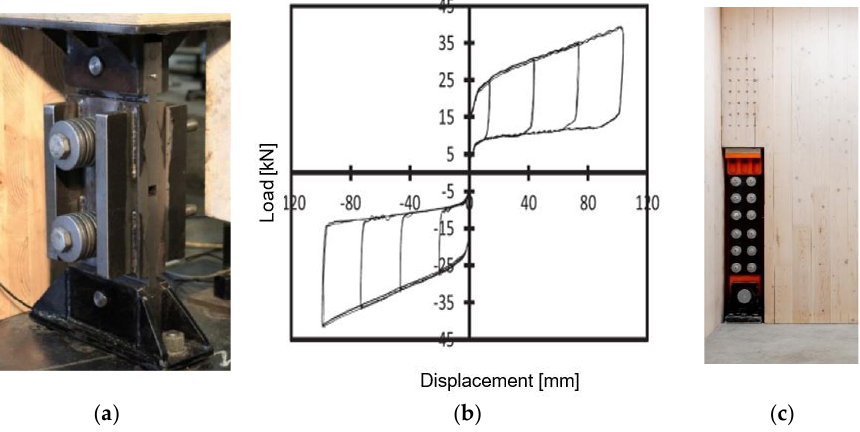
Figure 9. RSF HD: ( a ) close-up view; ( b ) force–displacement (photo credit: Ashkan Hashemi, reprinted with permission); ( c ) commercial application (photo credit: Fast + Epp, reprinted with permission)